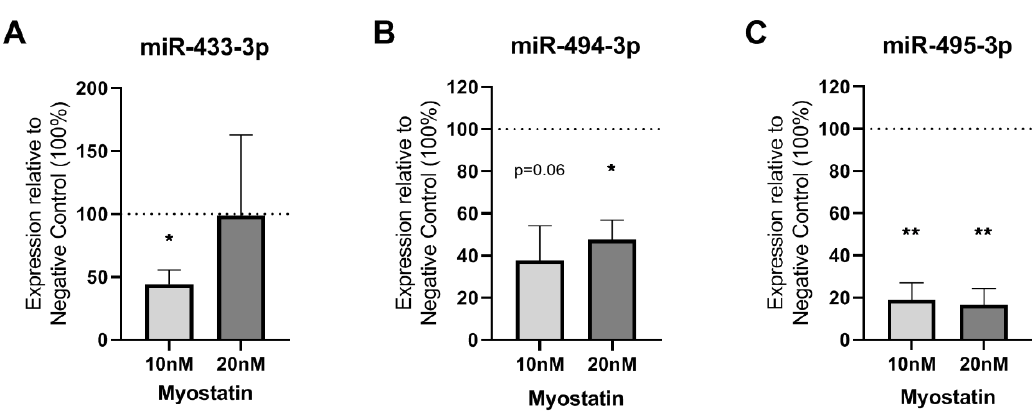
Figure 2. A-C: microRNAs in myostatin treated VSMCs relative to untreated control (100%). A —miR- 433-3p expression in VSMCs treated with 10 nM and 20 nM myostatin only showed a downregulation at 10 nM treatment ( p = 0.04). B —miR-494-3p expression in VSMCs treated with 10 and 20 nM myostatin was downregulated at 20 nM treatment ( p = 0.03) and showed a trend towards downregulation at 10 nM myostatin ( p = 0.06). C —miR-495-3p expression in VSMCs treated with 10 and 20 nM myostatin was decreased with more than 80% by both treatment concentrations ( p = 0.0098 and p = 0.0088, respectively). Mean expression is shown and error bar represents SEM ( n = 3). One- sample t -test performed with 100% of control expression as hypothetical value. * p < 0.05, ** p < 0.01.